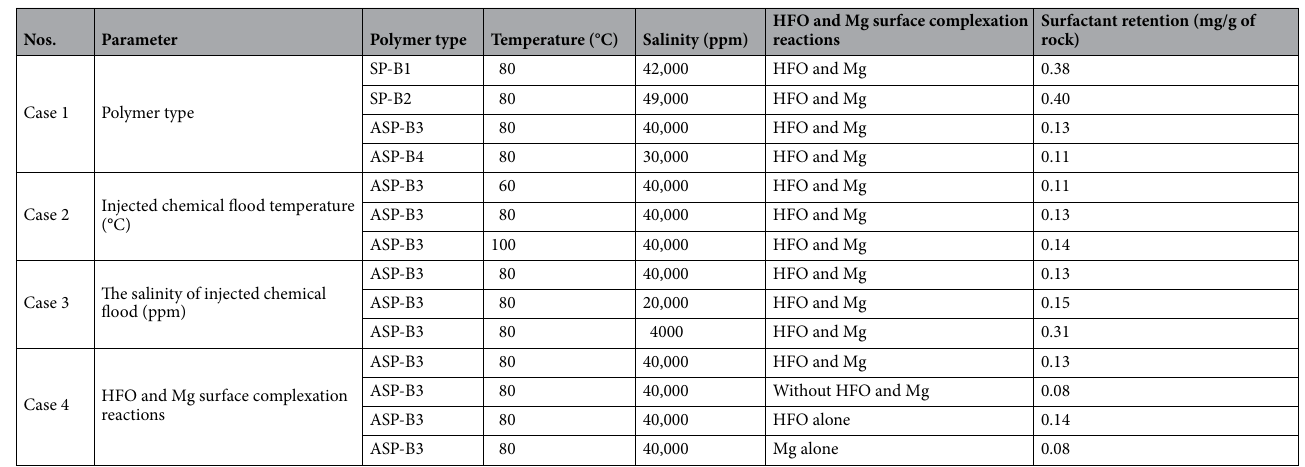
Table 12. Surfactant retention determined using the developed SCM for the two-phase sensitivity analysis study.